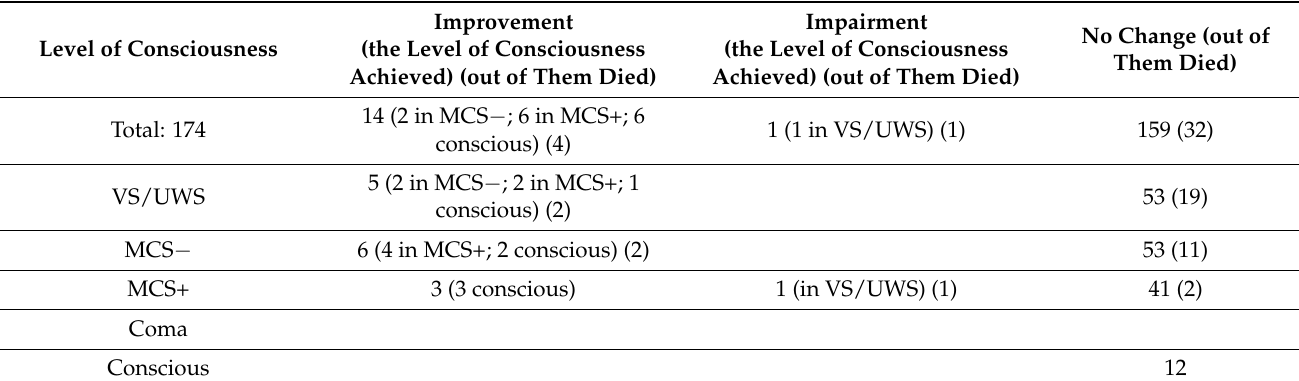
Table 6. Changes in the level of consciousness at the 12 month checkpoint.